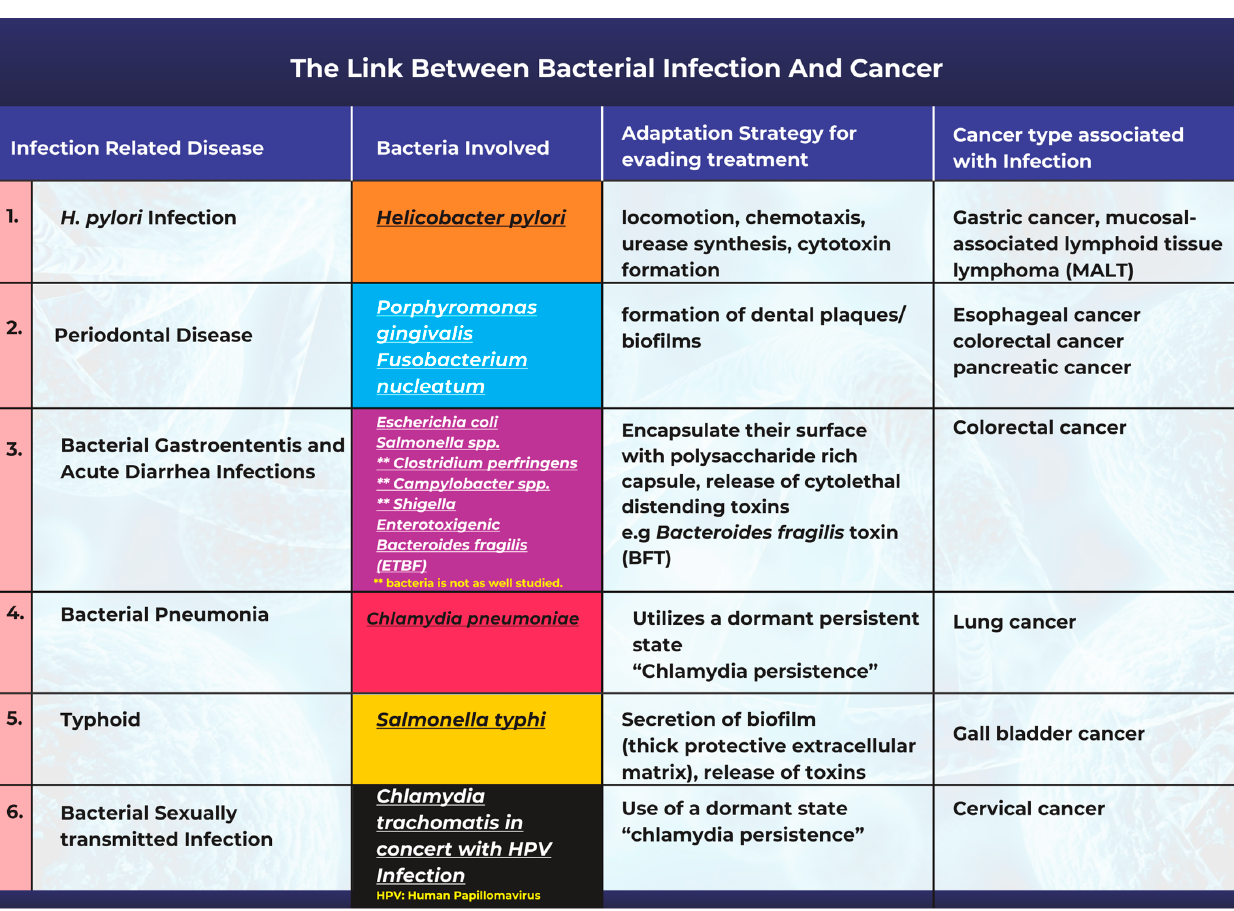
Figure 1. An illustration of the links between common bacterial infections and cancer.